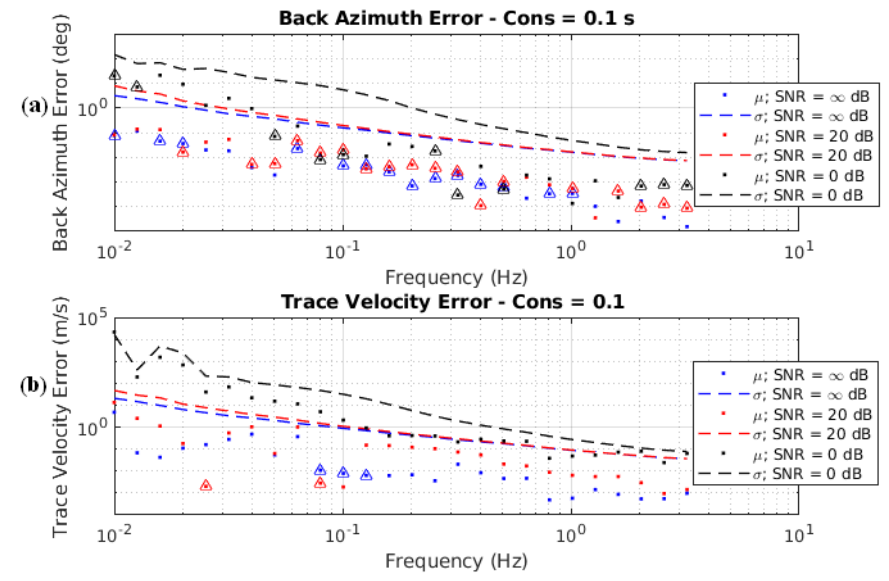
Figure 14. Plots (log-scales) of the absolute values of the ( a ) back azimuth and ( b ) trace velocity mean errors (bias) (points) and standard deviations (dashed lines) as functions of frequency for the microbarometer. The colors represent the different noise levels; blue is infinite SNR (no noise), red is an SNR of 20 dB, and black is 0 dB. The triangles denote the negative